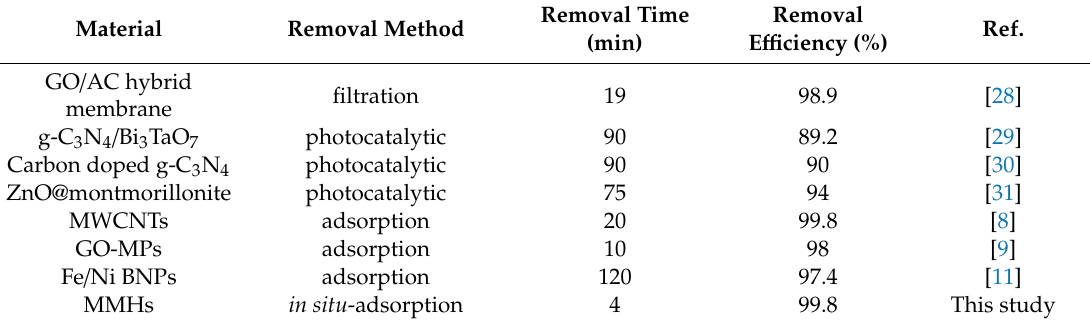
Figure 3. The effect of ( a ) mixed metal concentrations and ( b ) contact time on the removal efficiency Figure 3. The e ff ect of ( a ) mixed metal concentrations and ( b ) contact time on the removal e ffi ciency of of TC in aqueous solution at an initial concentration of 30 mg L − 1 . TC in aqueous solution at an initial concentration of 30 mg L − 1 . Table 1. Comparison of the removal of TC by the proposed method with other Table 1. Comparison of the removal of TC by the proposed method with other methods.